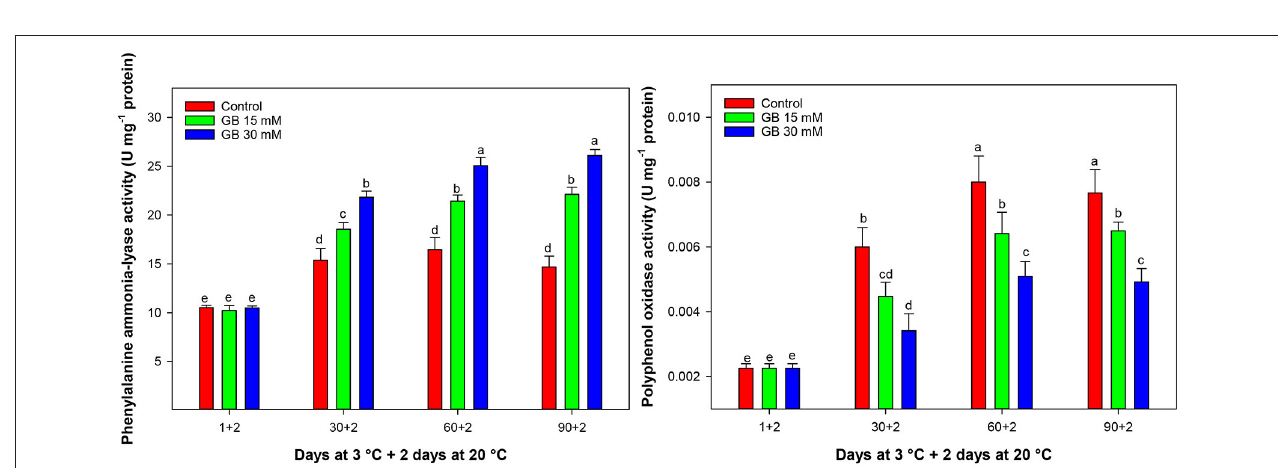
FIGURE 7 | Changes in phenylalanine ammonia-lyase (PAL) and polyphenol oxidase (PPO) activities in control and GB-treated of “Moro” blood orange at 3 ◦ C. Different letters and vertical bars show significant difference ( p < 0.05) and standard errors ( ± SE) of means, respectively.